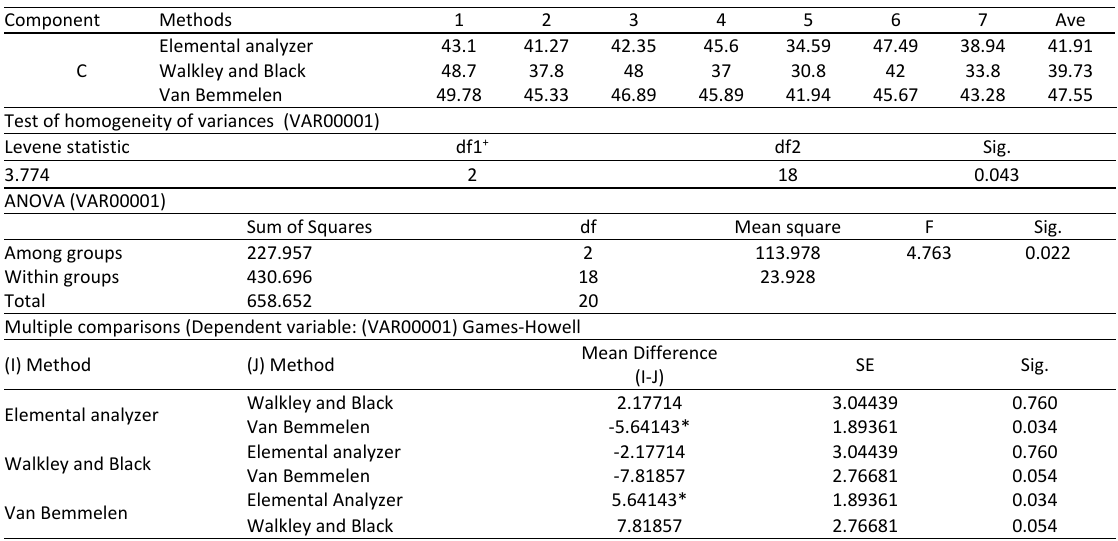
* Significance Table 6: Statistical analysis of carbon determination, test of homogeneity of variances, ANOVA, and multiple comparisons through different laboratory methods Component